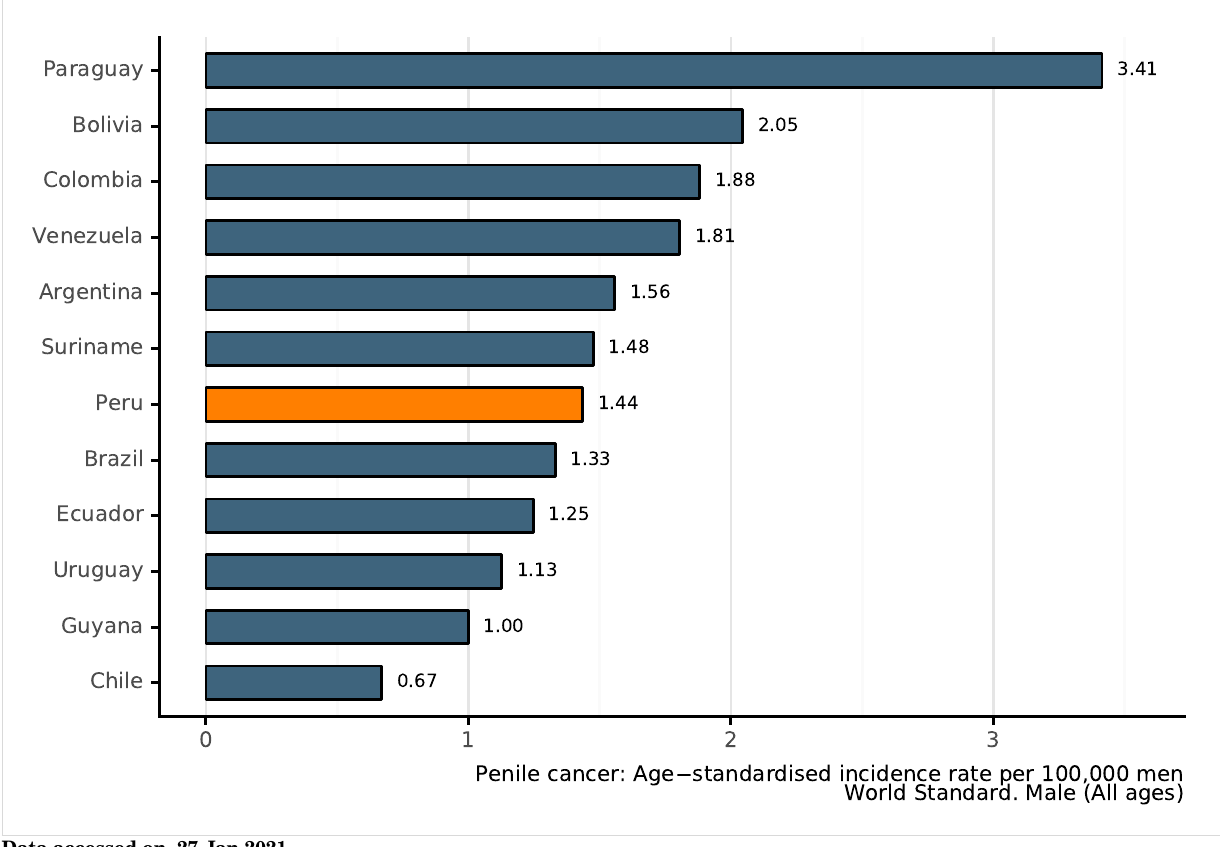
Figure 87: Age-standardised incidence rates of penile cancer of Peru (estimates for 2020)